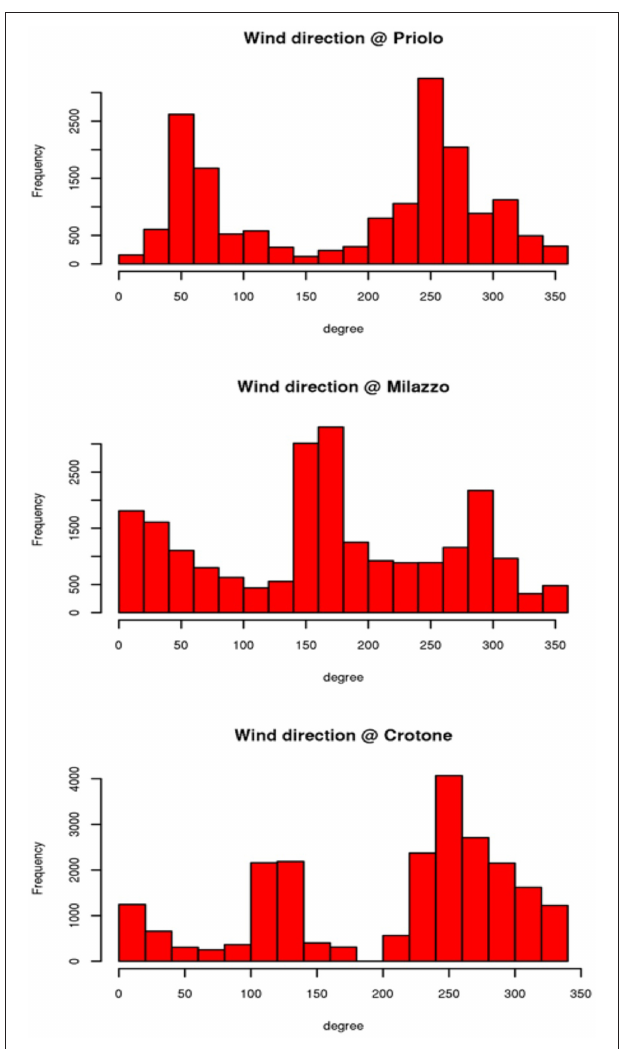
FIGURE 4 | Histograms of frequency of hourly wind direction at the sampling sites as described in Figure 3 .